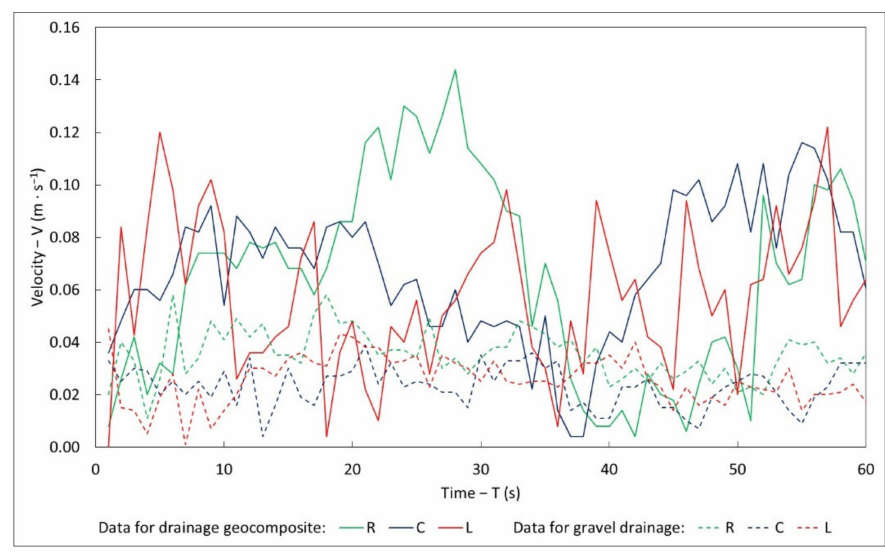
Figure 7. Section of a 60 s transient velocity measurement result from a 0.18 m column of water over the top plane of the research objects (for drainage geocomposite and gravel drainage).